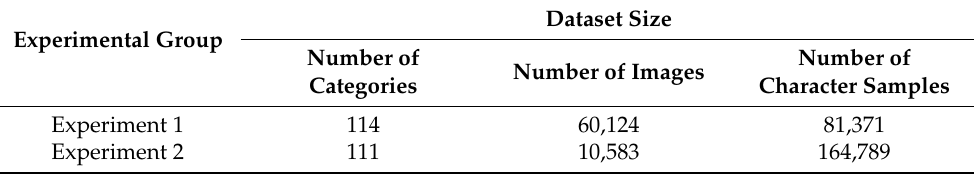
Table 3. Datasets information for the two sets of experiments. Experimental